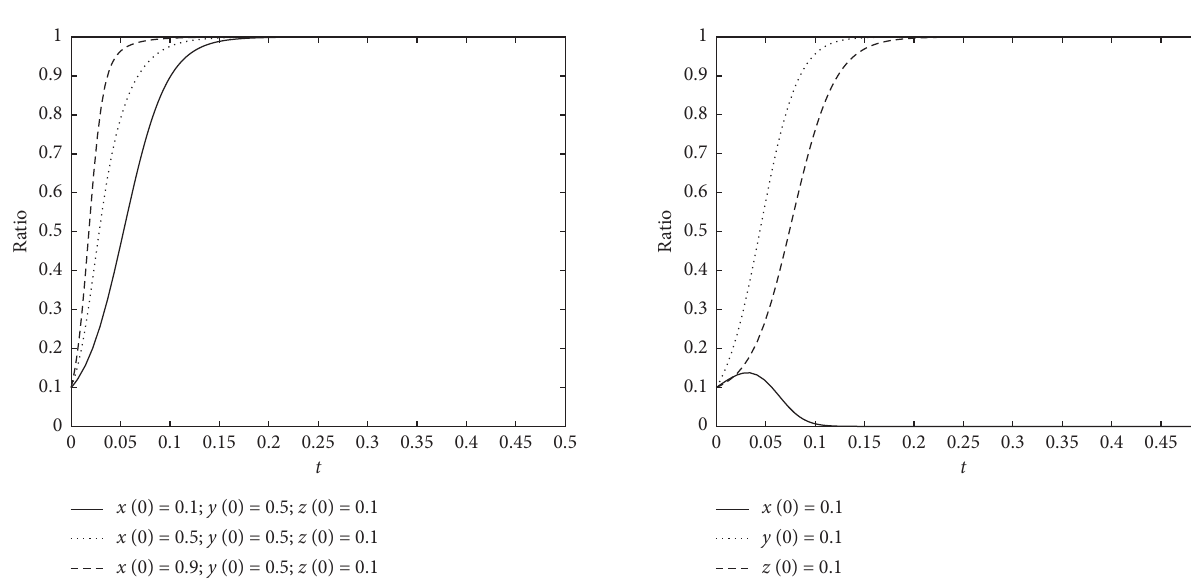
Figure 6: Dynamic evolution process of the game’s different